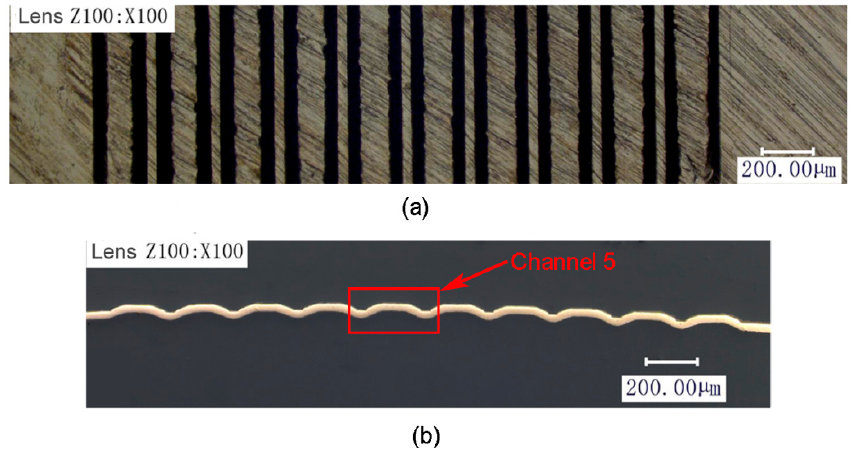
Figure 7. Image of the formed part under the laser energy of 1800 mJ: ( a ) 2 ‐ D morphology of the whole formed part and ( b ) cross ‐ section morphology of ten array channels.